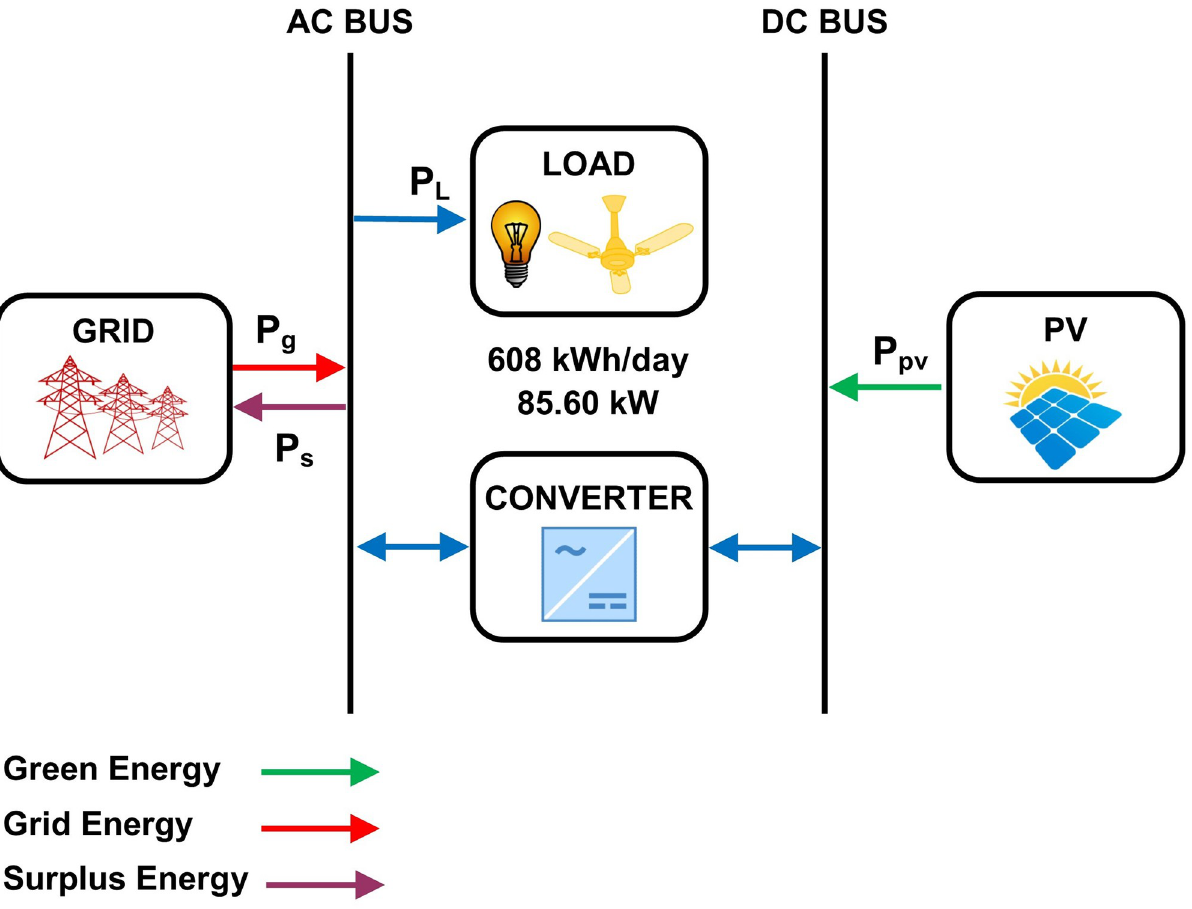
Fig 4. The hybrid energy model-A for the prosumer